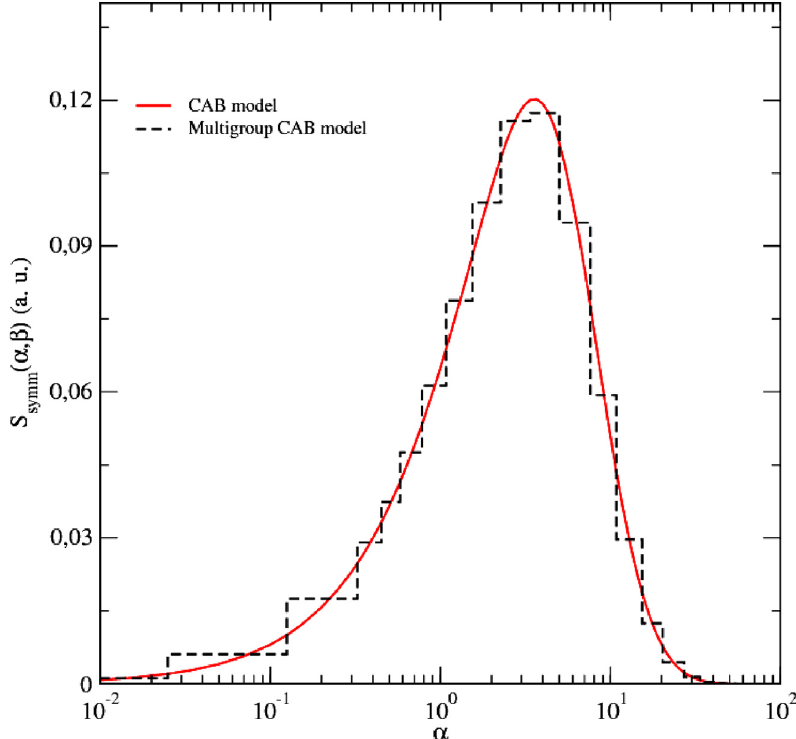
Fig. 5. Thermal scattering function S ( a , b 0 ) and its multigroup representation S ð a ; b 0 Þ as a function of the momentum transfer for b 0 = 1.0 calculated with the CAB model at